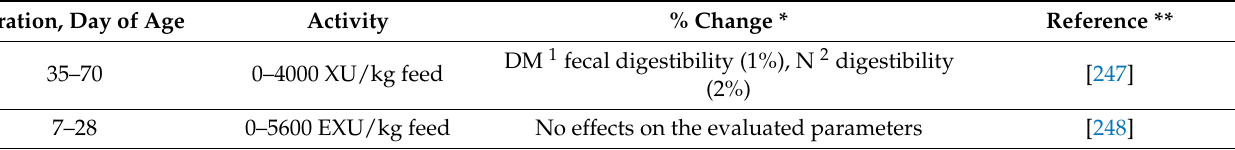
Table 4. A list of studies describing effects of xylanase supplemented individually at different levels in diets for nursery